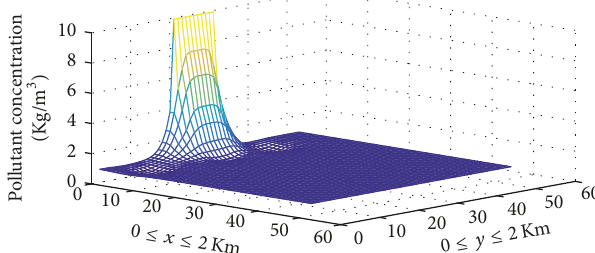
Figure 7: Approximated pollutant concentrations when the first zonal removal mechanism system is activated.